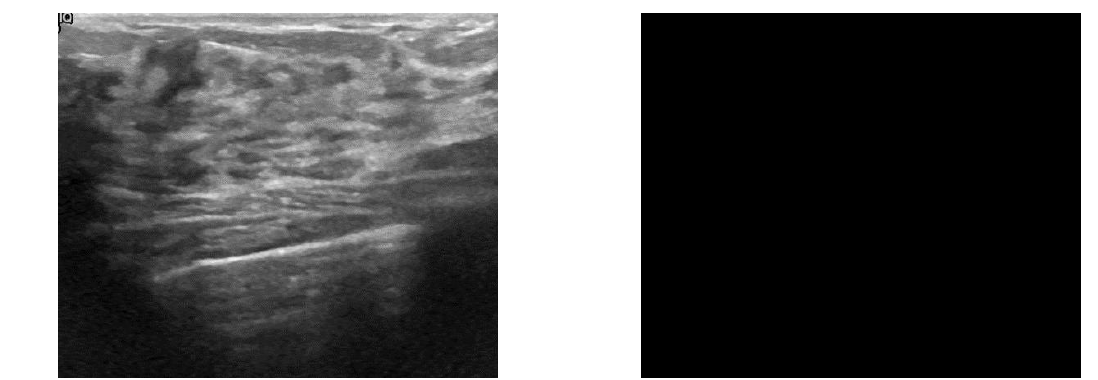
Figure 1. Ultrasound and clustered images of breast cancer for benign, malignant, and normal tissue conditions.